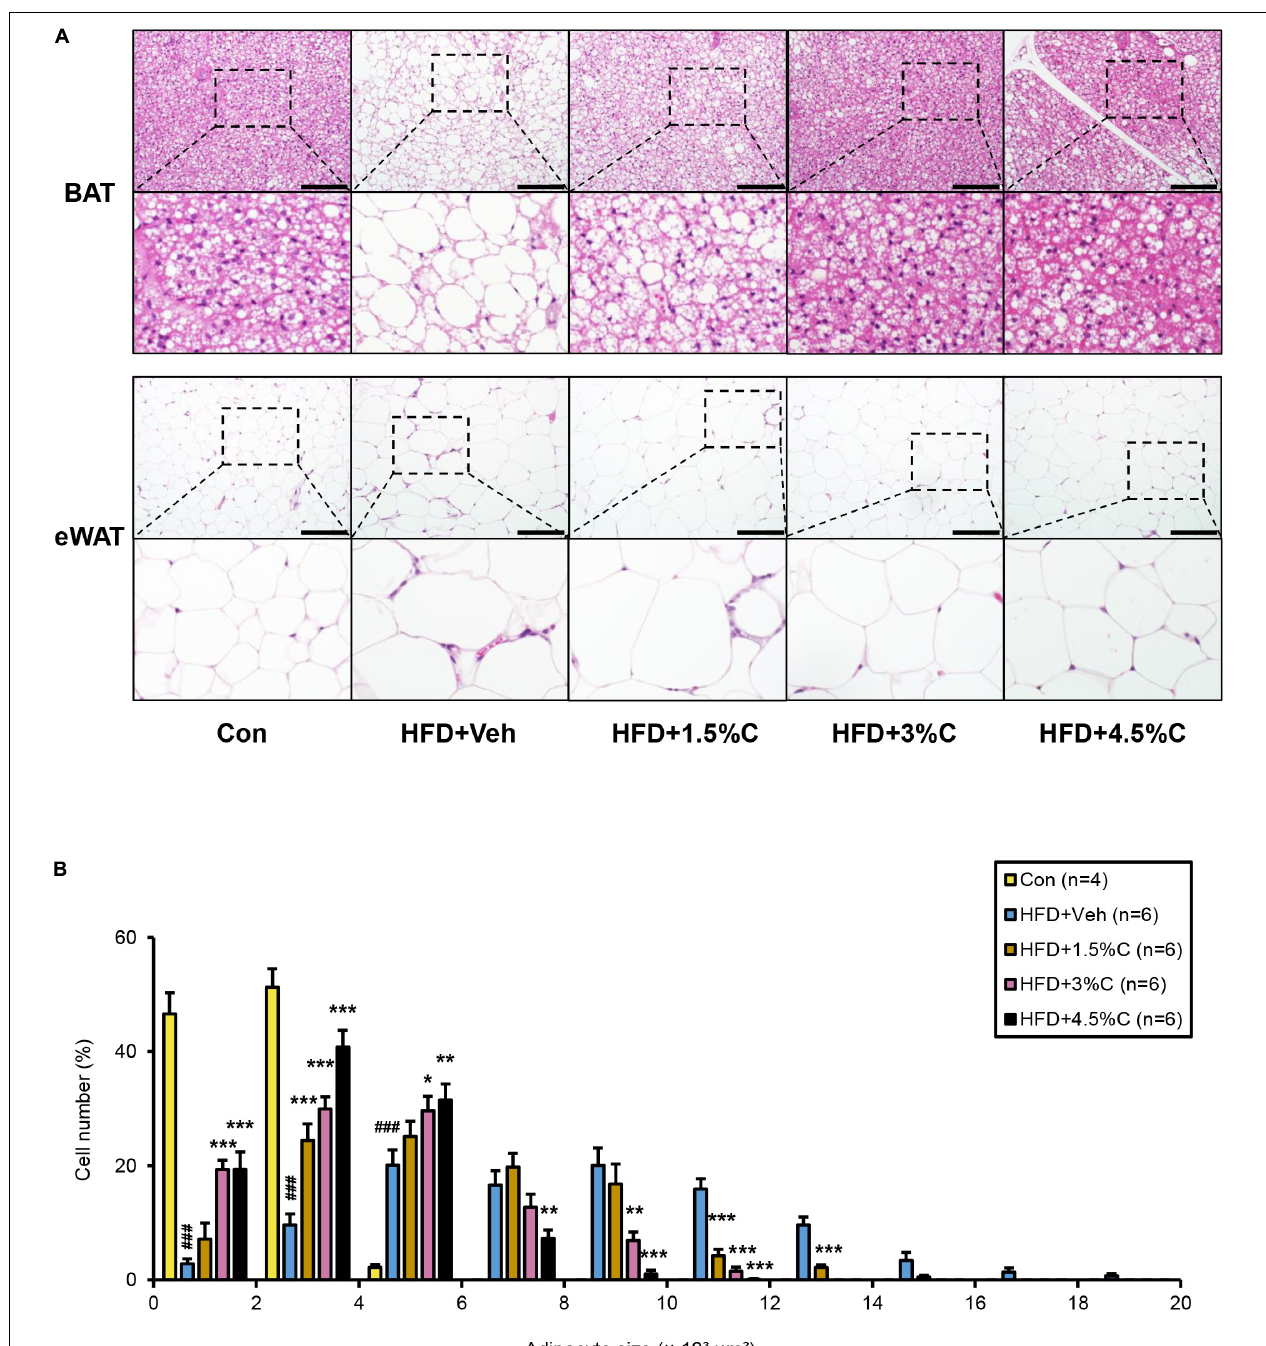
FIGURE 8 | Changes in histological appearance after treatment with different dosages of acidic activated charcoal. (A) Histological appearance of BAT and eWAT. The sections were stained with hematoxylin and eosin. Scale bars = 150 µ m (x200 magnification). (B) Proportions of adipocytes of different sizes. Data are expressed as the mean ± SEM. Statistical analysis was performed using a one-way analysis of variance (ANOVA) with the Bonferroni’s correction. * P < 0.05, ** P < 0.01, and *** P < 0.001 between the HFD + Veh group and the HFD + C group. ### P < 0.001 between the HFD + Veh group and the Con group.